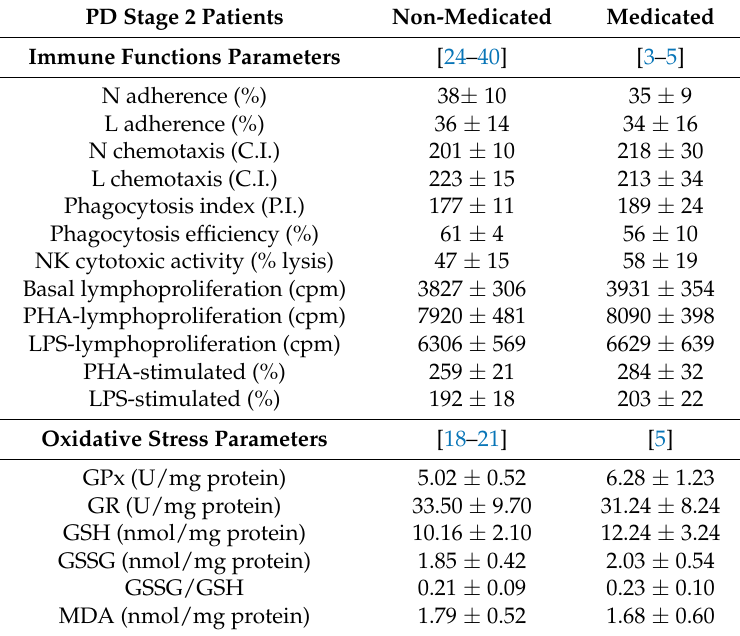
Table 1. Immune function parameters in isolated peripheral blood neutrophils (N) and mononuclear cells (L), and oxidative stress and lipid peroxidation parameters in whole blood cells from Parkinson’s Disease (PD) stage 2 patients, non-medicated and medicated with levodopa therapy for more than six